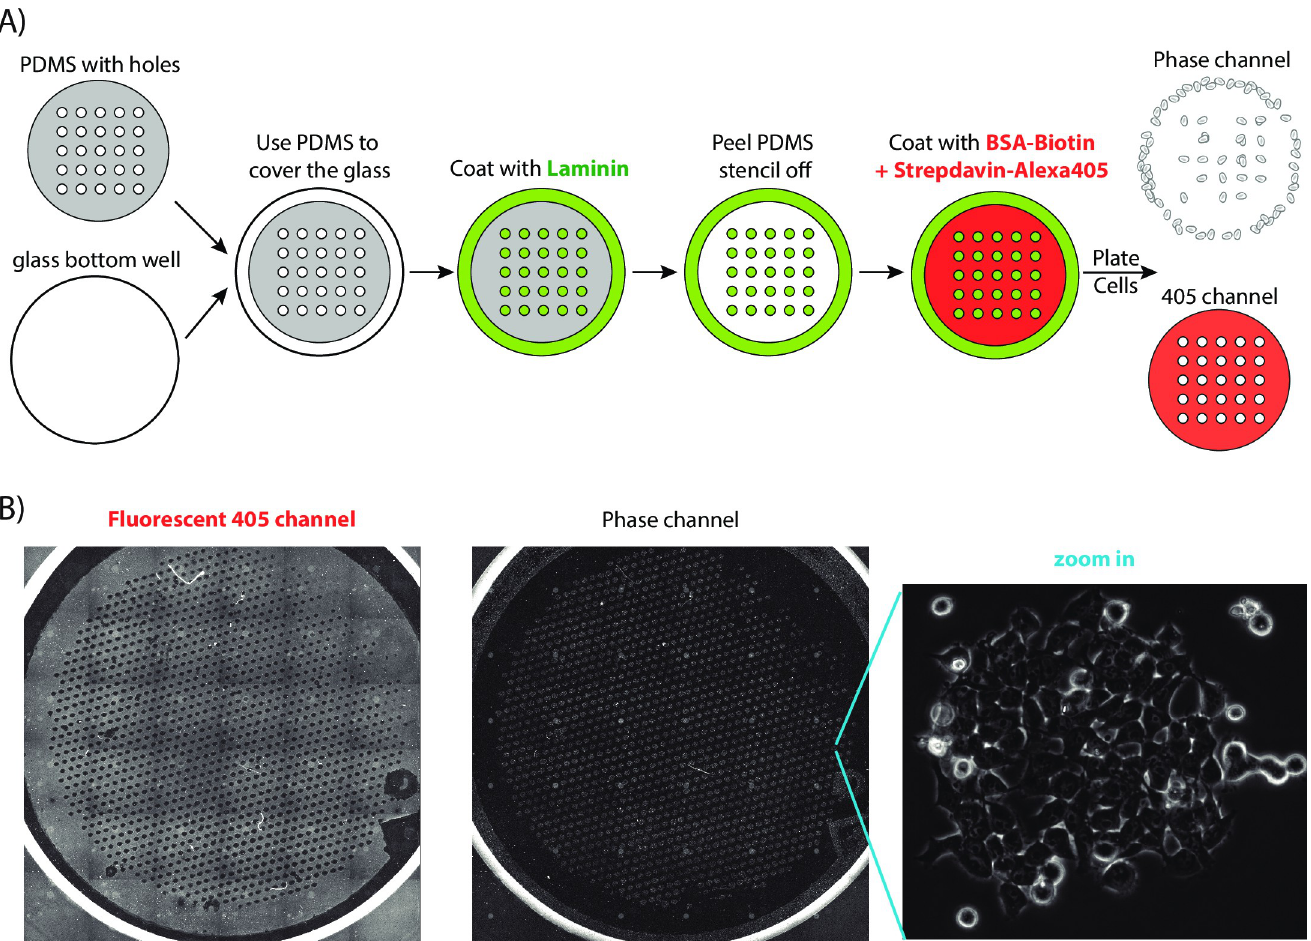
Fig 2. ESCs stayed in the high-adhesive patterned confined area. (A) We have used the fabricated PDMS with ~1000 holes as the stencil to coat the glass surface into high-adhesive zones (with laminin, green) and low-adhesive zones (with BSA, labeled with Alexa 405, red). (B) When plating ESCs onto the patterned surface, they formed well-shaped cell colonies in the high-adhesive zones. Worth mentioning, there are some mysterious shaded lines and colonies with high-intensity in the left and middle images. This is because, in order to cover the entire glass bottom of the 35mm culture dish, we have scanned the surface with 36 overlapping images then pieced them up. The uneven high-intensity and shade were generated due to the